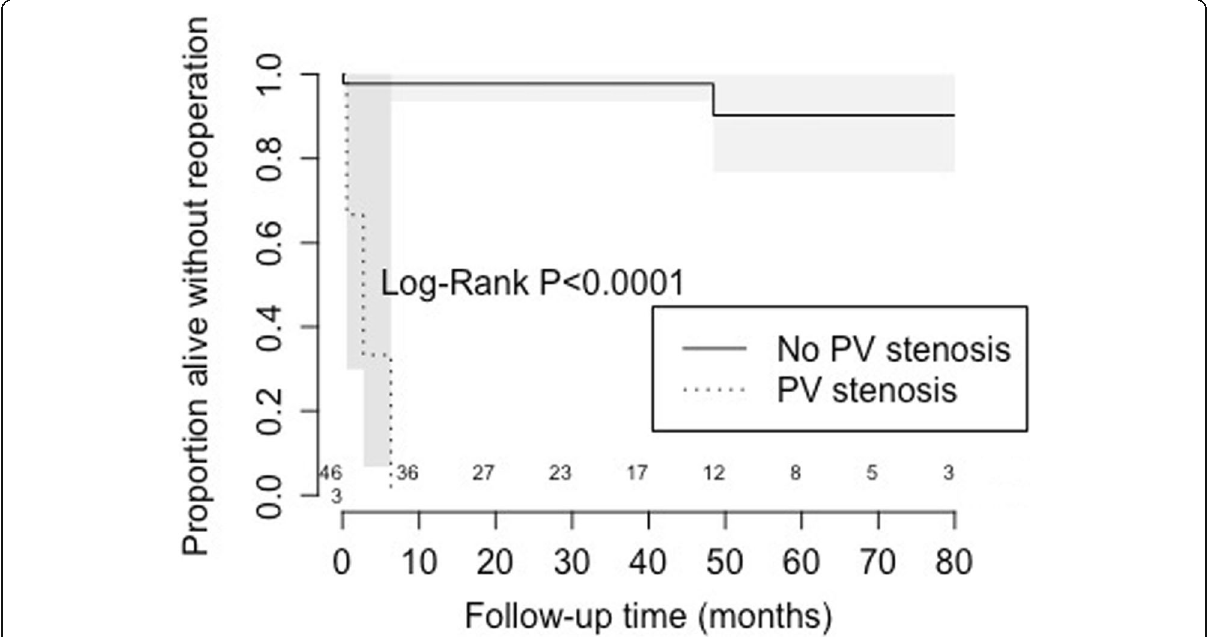
Fig. 1 Kaplan-Meier freedom from death or reoperation in patients who developed postoperative pulmonary vein stenosis and those who did